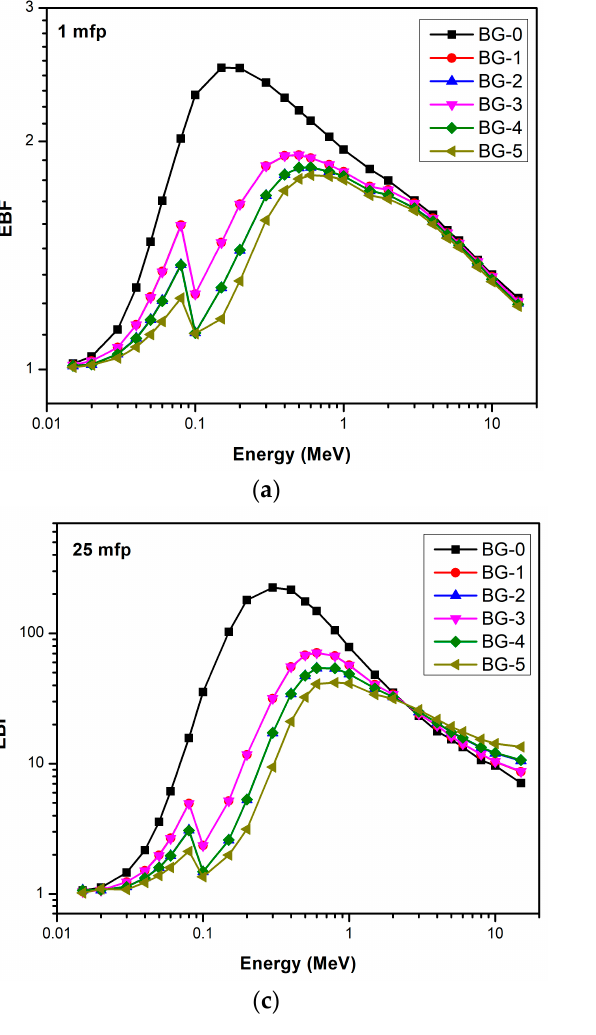
Figure 8. EBF as a function of photon energy at ( a ) 1mfp, ( b )15 mfp, ( c ) 25 mfp, and ( d ) 40 mfp for bismuth oxide bentonite–gypsum.